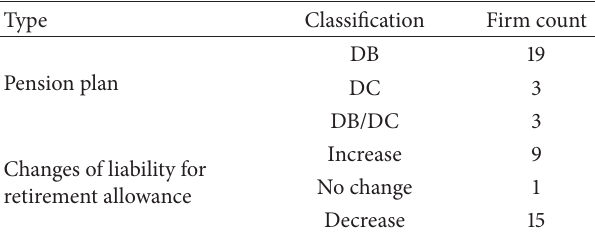
Table 3: Pension plan for firms with early K-IFRS